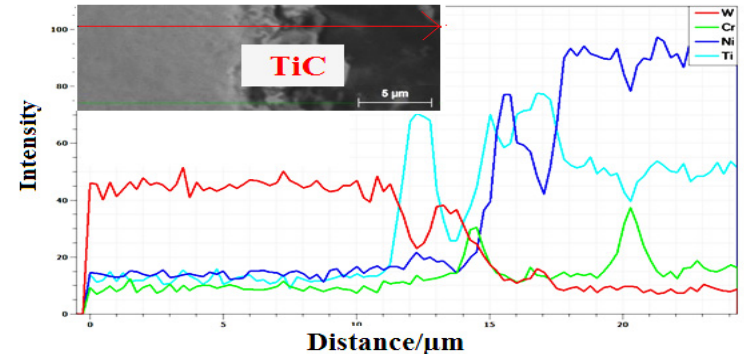
Figure 12. The EDAX compositional line scan of the interface of WC phase for sample processed at 59.5 J·mm − 2 .